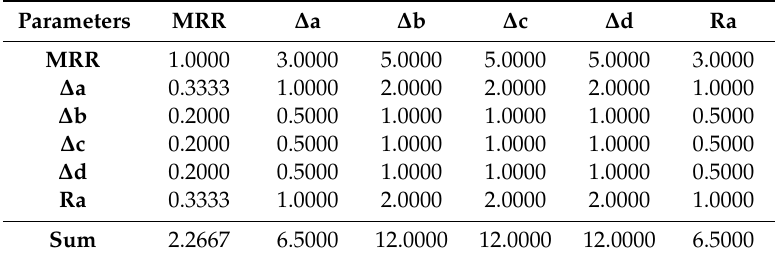
Table 4. Steps 1 and 2 of the approximation Analytic Hierarchy Process (AHP) methodology for determining weight coe ffi cients.